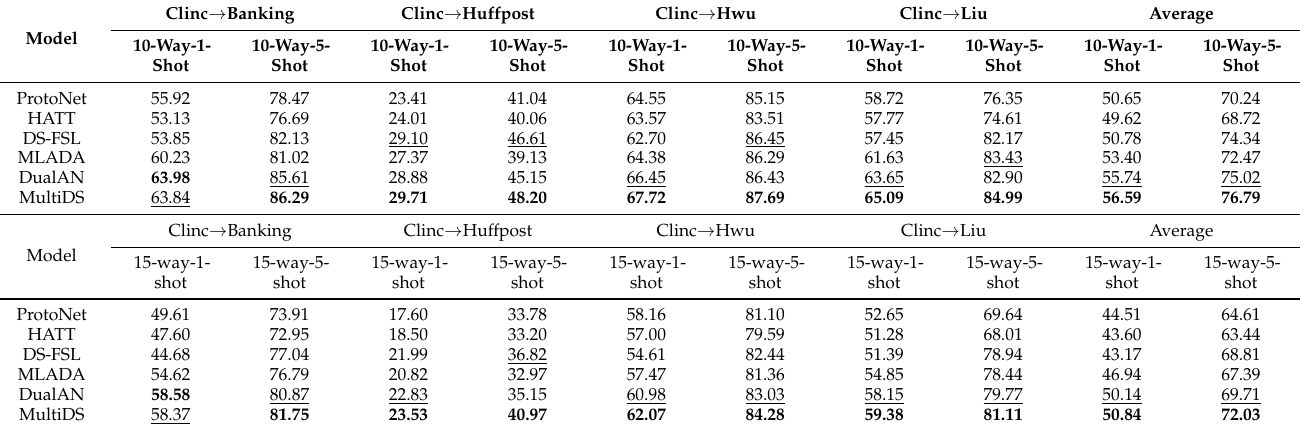
Table 5. Experimental results of all methods on Clinc → Banking, Clinc → Huffpost, Clinc → Hwu and Clinc → Liu, respectively. The best and second best results are emphasized using bold fonts and underlines,